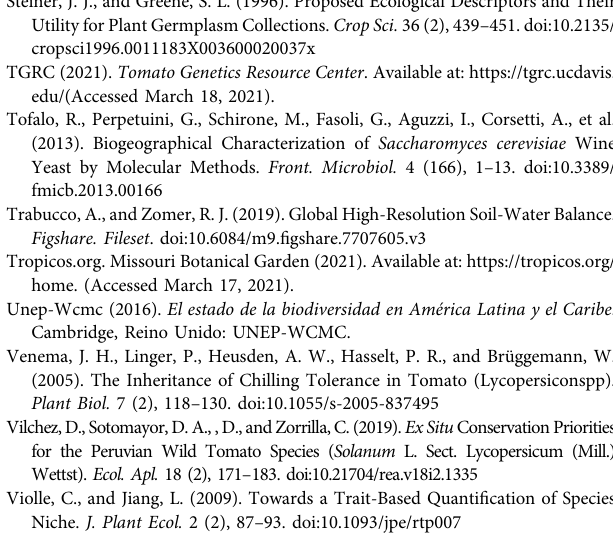
Figshare. Fileset . doi:10.6084/m9. fi gshare.7707605.v3 Tropicos.org. Missouri Botanical Garden (2021). Available at: